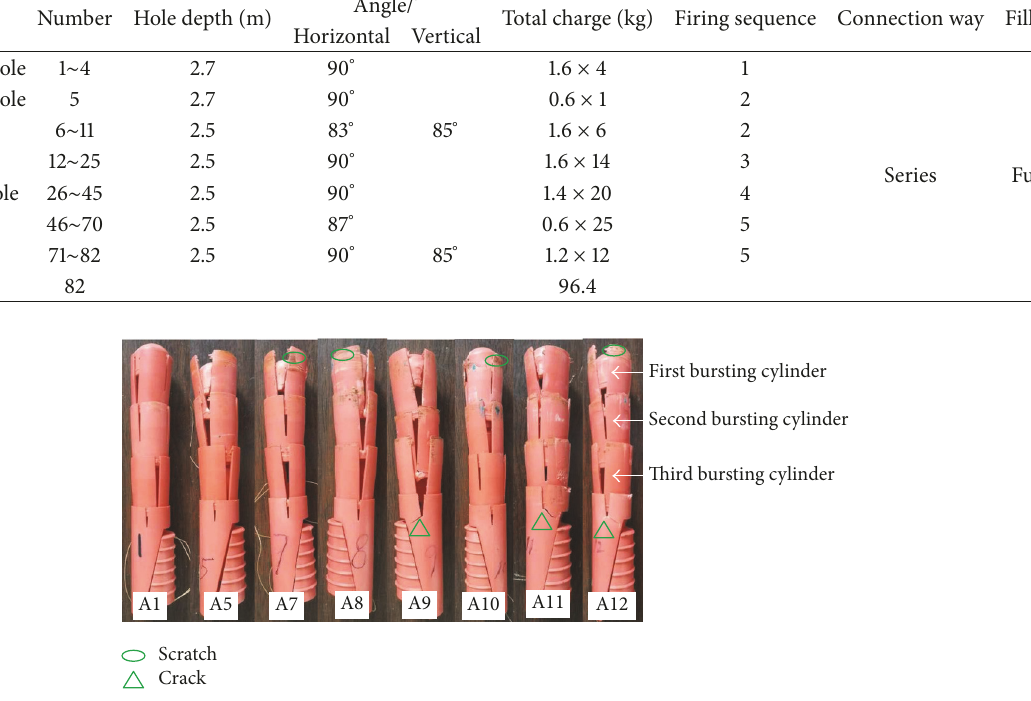
Figure 10: The scratch and crack of the plug after the impact